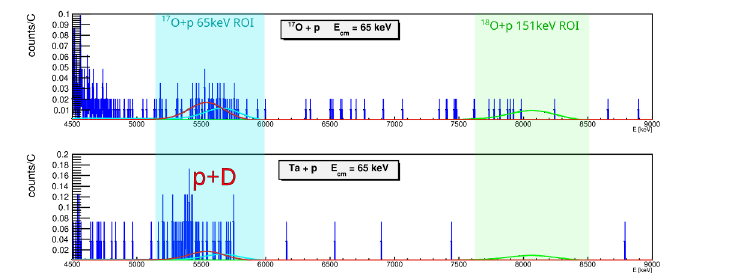
Figure 3. Spectra acquired shooting a E lab = 80keV proton beam on 17 O (top) targets and naked Ta backings (bottom). The p + d peak in the bottom spectrum indicates a contamination in the Ta backings estimated at 3 p.p.m. level. The coloured peaks are shown to guide the